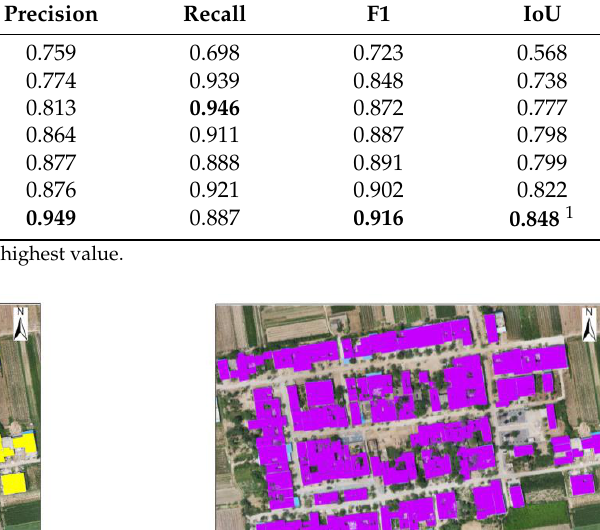
Figure 10. Spatial distribution of rural buildings in Helan village. ( a ) Ground truth of homesteads and ( b ) identification results based on the EDSANet model.